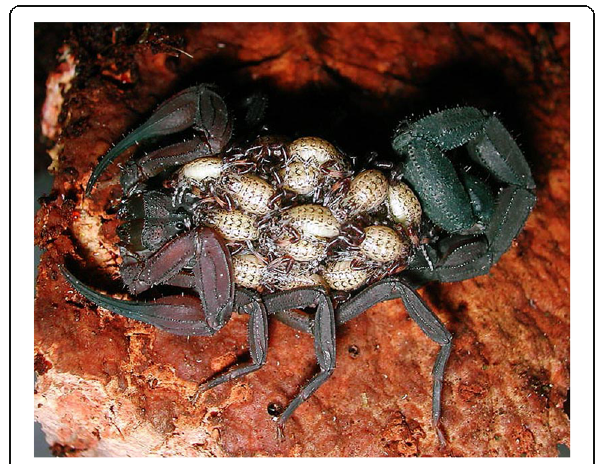
Fig. 12 Female specimen of Tityus ythieri from Ecuador with an average litter size of first instar pro-juveniles (copyright by Eric Ythier, reproduced with permission)